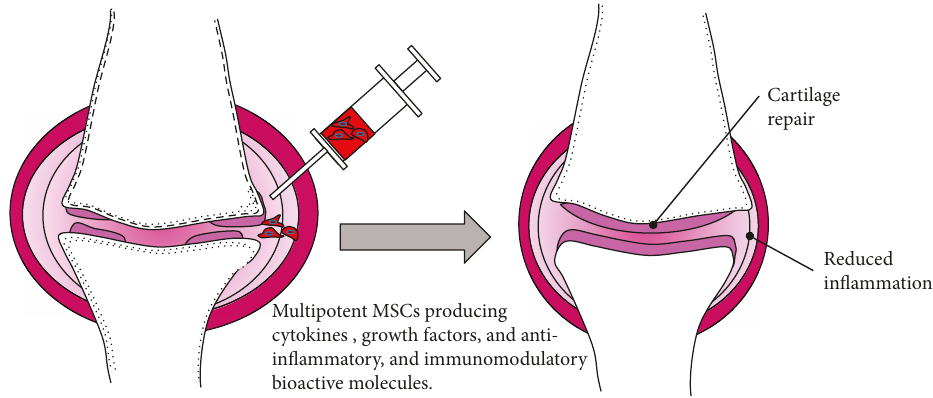
Figure 3: Model of regeneration of a knee joint before and after treatment with